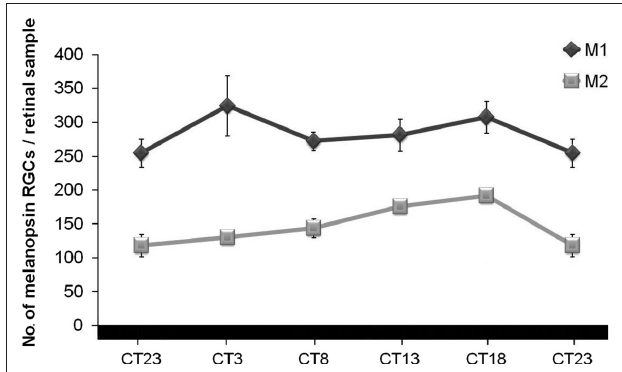
FIGURE 7 | Numbers of M1 and M2 cells under DD conditions. While M1 cells maintained rather constant values, signifi cant oscillation was observed for M2 cells (one-way ANOVA test: p < 0.01). A decrease in the number of M2 cells at the end of the subjective night ( p < 0.05) was detected by a post hoc test. ( n = 4 per group at each